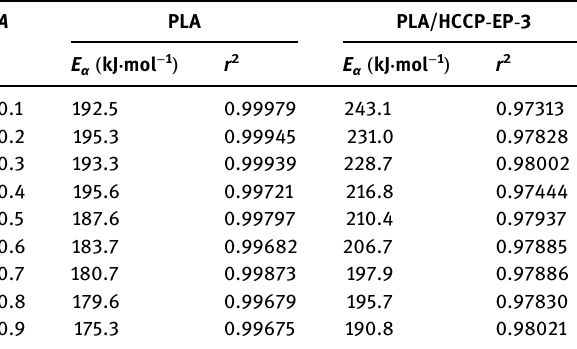
Table 3: Calculated E α and r 2 of PLA and PLA/HCCP - EP - 3 under di ff erent fractional conversion